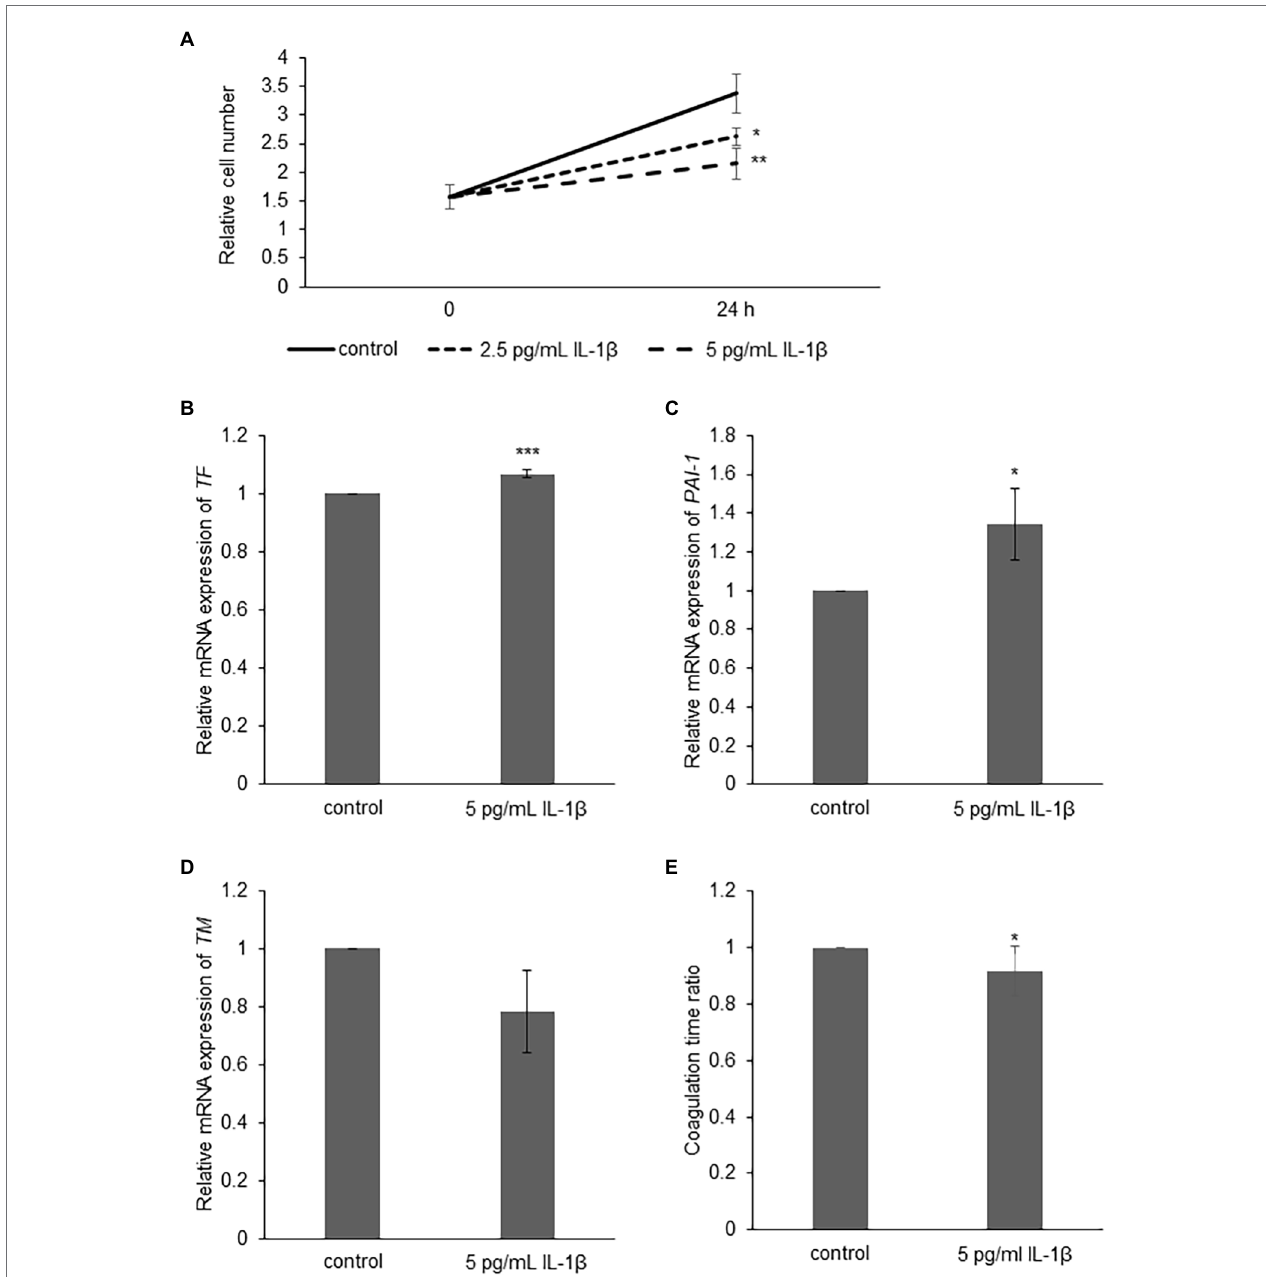
FIGURE 5 | The effect of IL-1 β on Ea.hy926 cells. (A) Ea.hy926 cells were treated with 2.5 and 5 pg/ml of IL-1 β for 24 h. After the treatment, the proliferation of Ea.hy926 cells was examined by XTT assay. The data are shown as mean ± SD ( n = 3). Significant differences are indicated as * for p < 0.05 and ** for p < 0.01 between control and others at 24 h time point. (B-D) Ea.hy926 cells were treated with 5 pg/ml of IL-1 β for 24 h. After the treatment, the cells were harvested for qRT-PCR assay. (B) The mRNA expression of tissue factor ( TF ), (C) mRNA expression of Plasminogen activator inhibitor-1 ( PAI-1 ), and (D) thrombomodulin ( TM ) were analyzed by qRT-PCR assay. The expression was normalized to GAPDH mRNA. The data are shown as mean ± SD ( n = 3). Significant differences are indicated as * for p < 0.05 and *** for p < 0.001 between control (showed as 1) and stimulated one. (E) Ea.hy926 cells were treated with 5 pg/ml of IL-1 β for 24 h. After the treatment, the cells were harvested for procoagulant activity (PCA) assay. The PCA on Ea.hy926 cells was measured by normal plasma-based recalcification time. The shortening of coagulation time indicates increased PCA. The value of vertical axis showed the coagulation time of control as 1. The data are shown as mean ± SD ( n = 5). Significant differences are indicated as * for p < 0.05 between control and stimulated